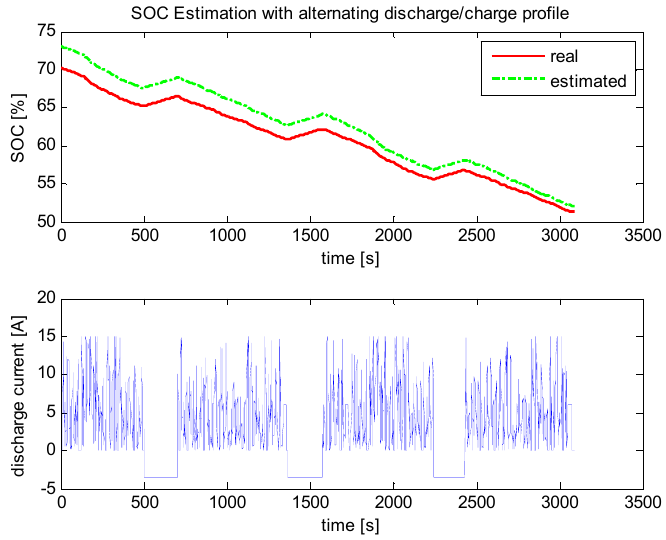
Figure 8. SOC estimation with an alternating discharge/charge profile.